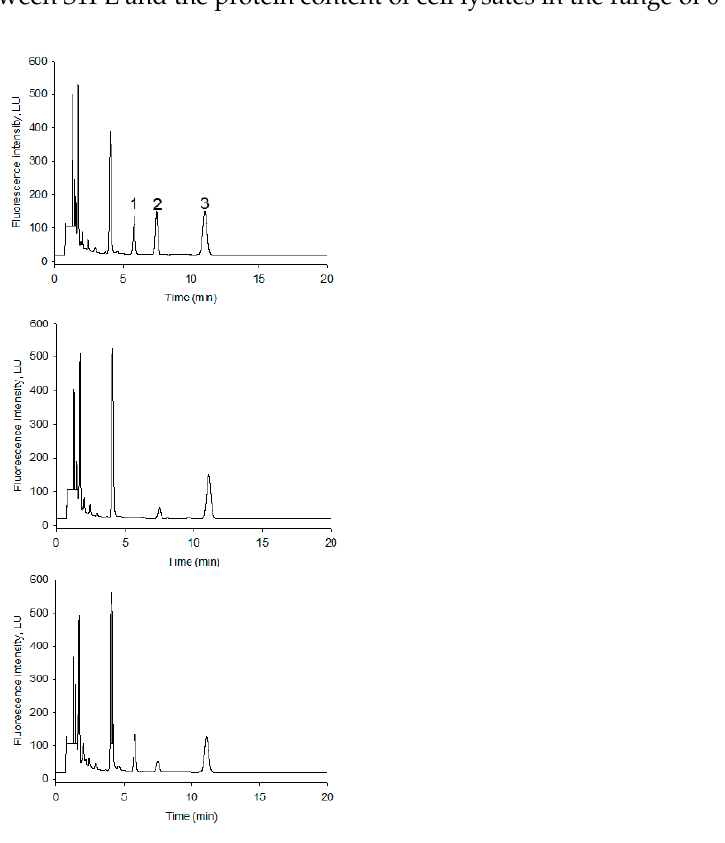
Figure 3. Typical HPLC–FLD chromatograms. Profile of 5,5-dimethyl CHD derivatives of ( A ) 100 pmol of pentadecanal, hexadecanal, and the heptadecanal standard solution. ( B ) Blank cell lyases with 100 pmol heptadecanal. ( C ) F9-4 cell S1PL activity after solid-phase extraction (SPE) and C18 reverse-phase HPLC–FLD with 90% methanol and 0.1% acetic acid as the elution. The SPE extraction yield was above 85%. 1: pentadecanal; 2: hexadecanal; 3: heptadecanal.